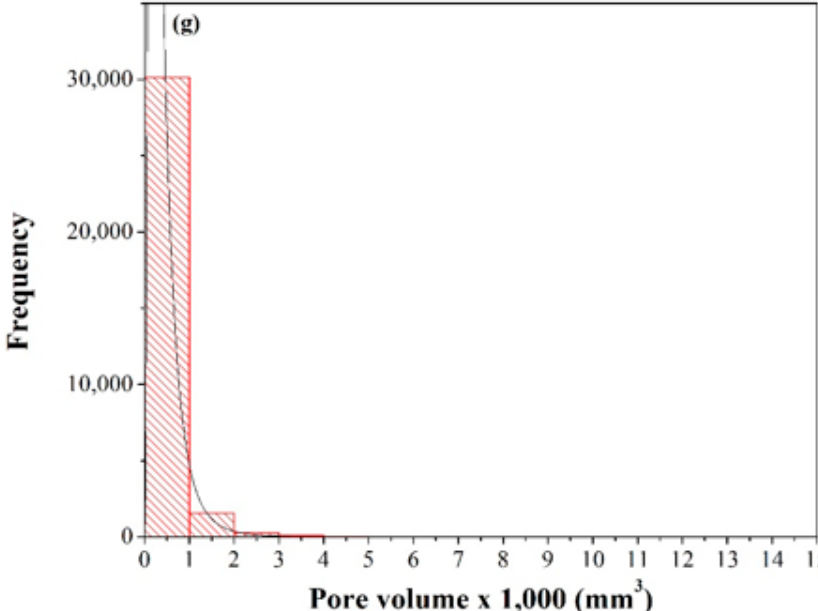
Figure 12. ( a – d ) X-ray µ -CT scan of the aluminum housing. Yellow areas mark possible voids. A higher density of defects at the interface between the substrate plate and the housing build is evident from ( c ). ( e , f ) µ -CT scanned pieces cut from the housing and scanned at higher resolution. Subfigures f1–f3 show the surface of the model and defects at different cross-sections (XYZ planes). ( g ) Pore size distribution in pieces of the aluminum housing with lognormal distribution fit.